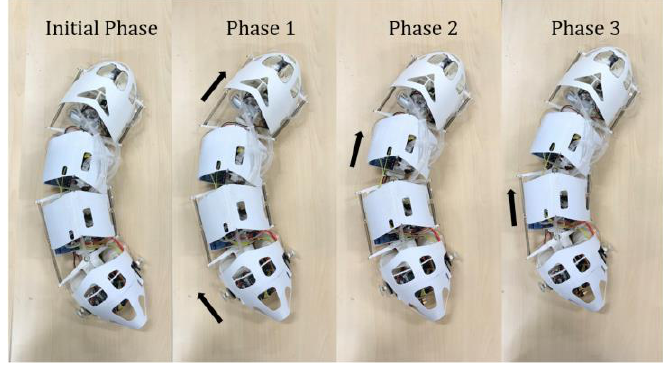
Figure 6. Steering crawling process in a single cycle.